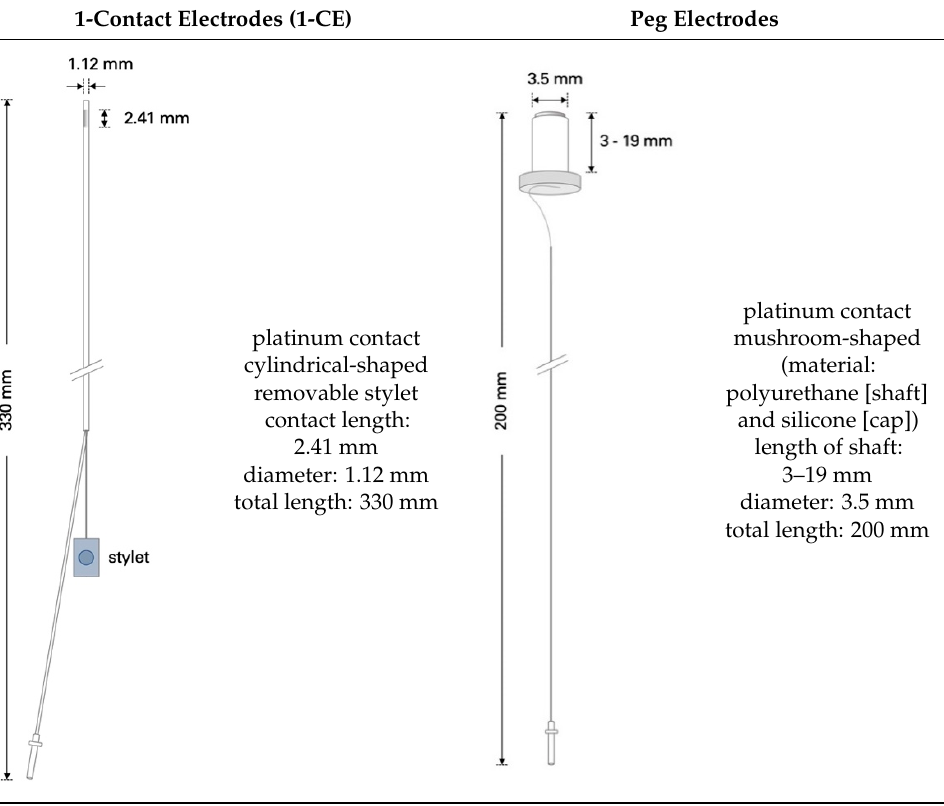
Table 1. Technical characteristics of 1-CE and Peg electrodes.